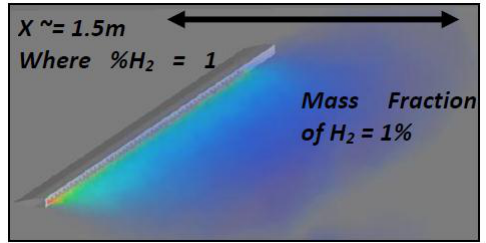
Figure 35. Integrated 3-D scramjet, H 2 injector render.